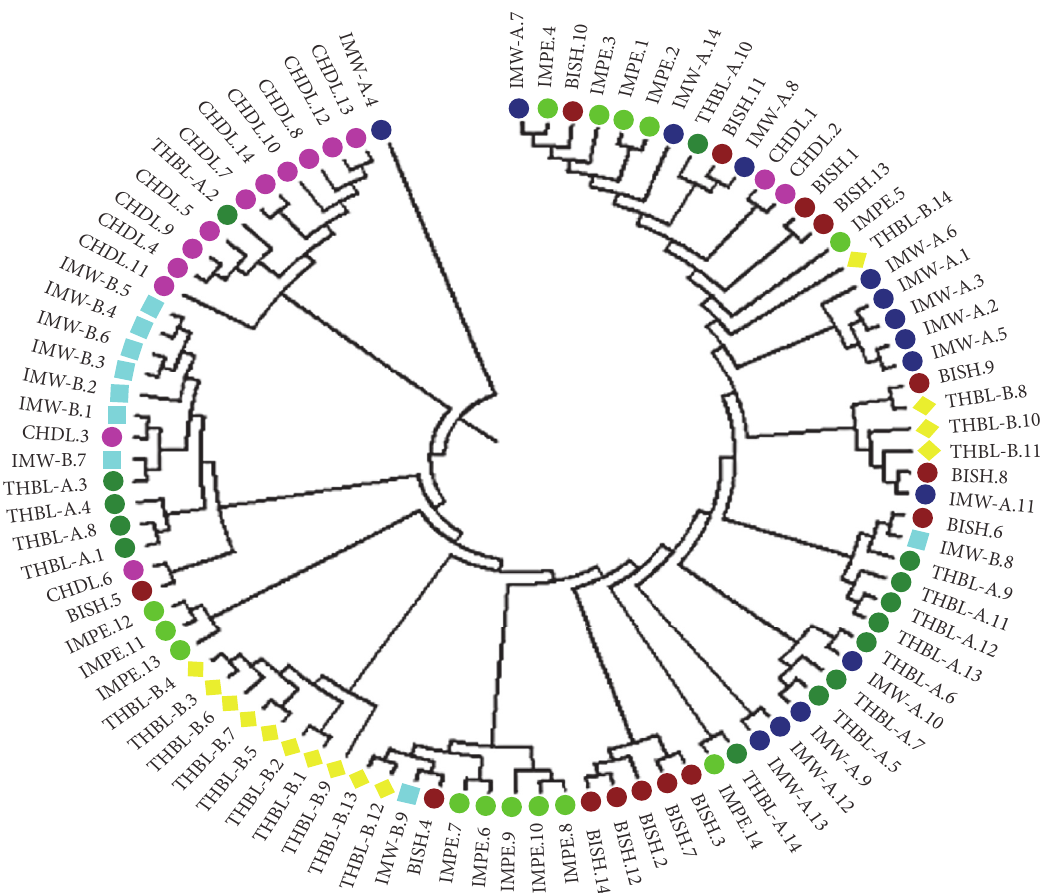
Figure 5: Neighbor-Joining dendrogram clustering pattern for 93 individuals belonging to 7 populations of M. baccifera.